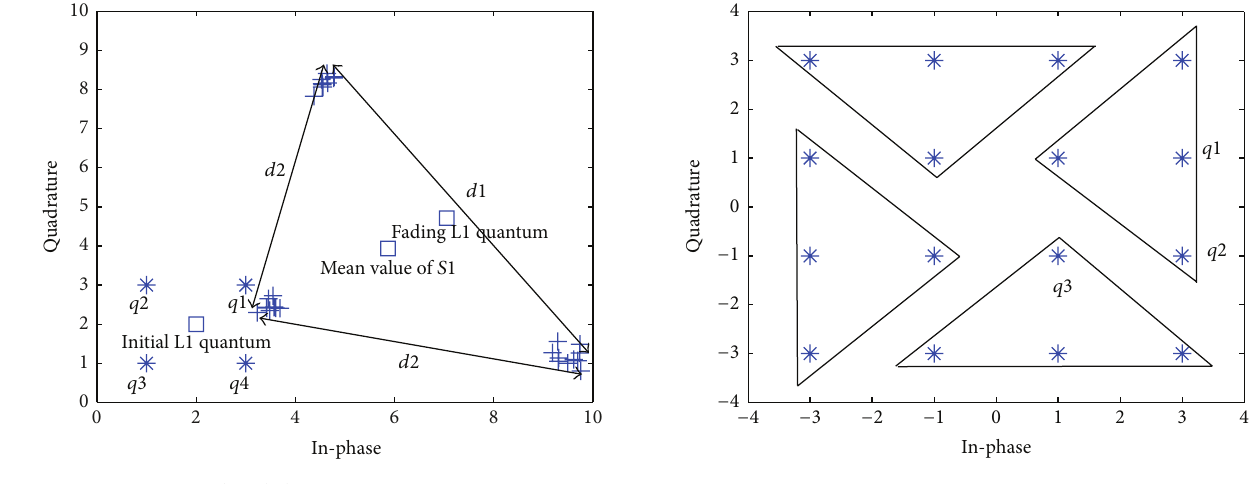
Figure 4: Subsets of square 16QAM